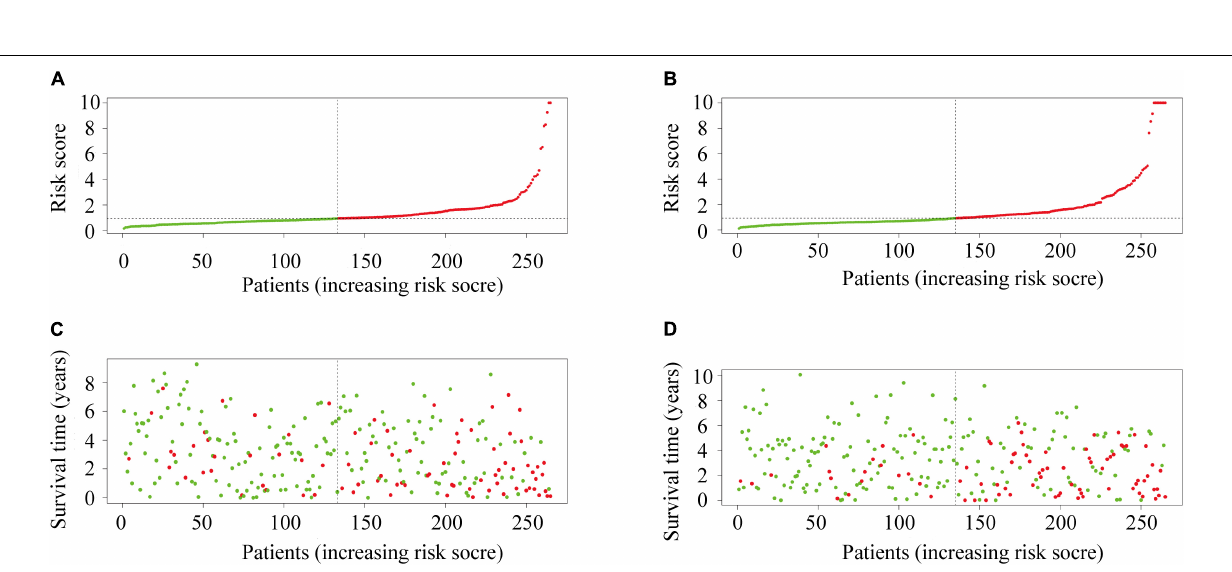
Frontiers in Genetics |